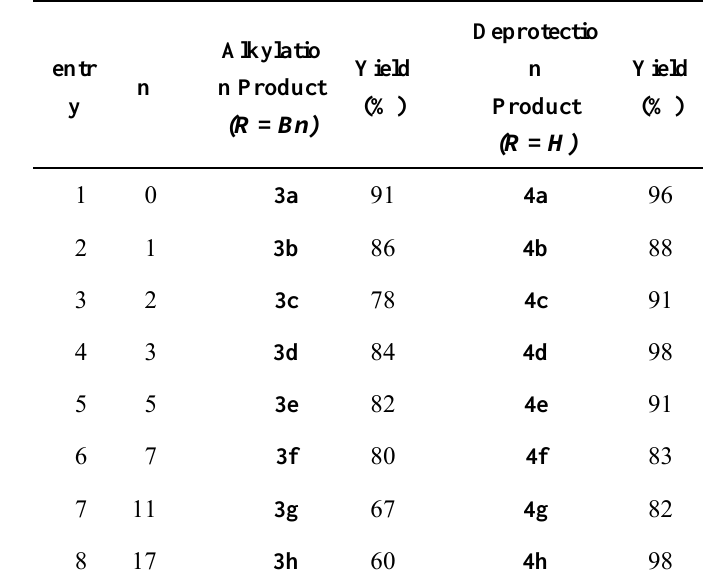
Table 1. Yields (%) of pure compounds obtained.